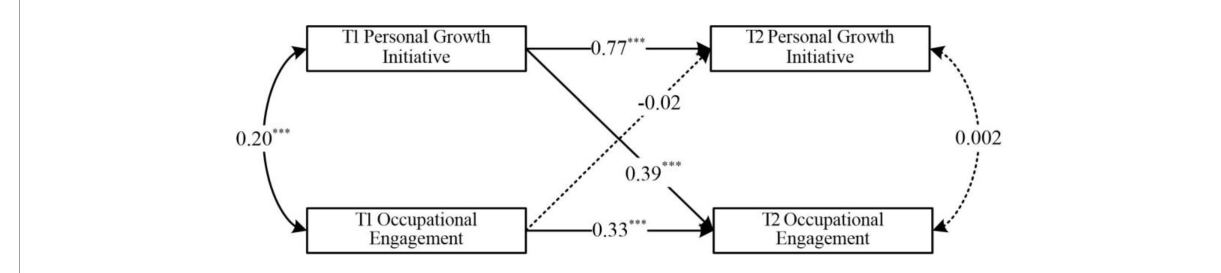
FIGURE1 A cross-lagged model of personal growth initiative and occupational engagement * p < 0.05, ** p < 0.01, and *** p < 0.001.